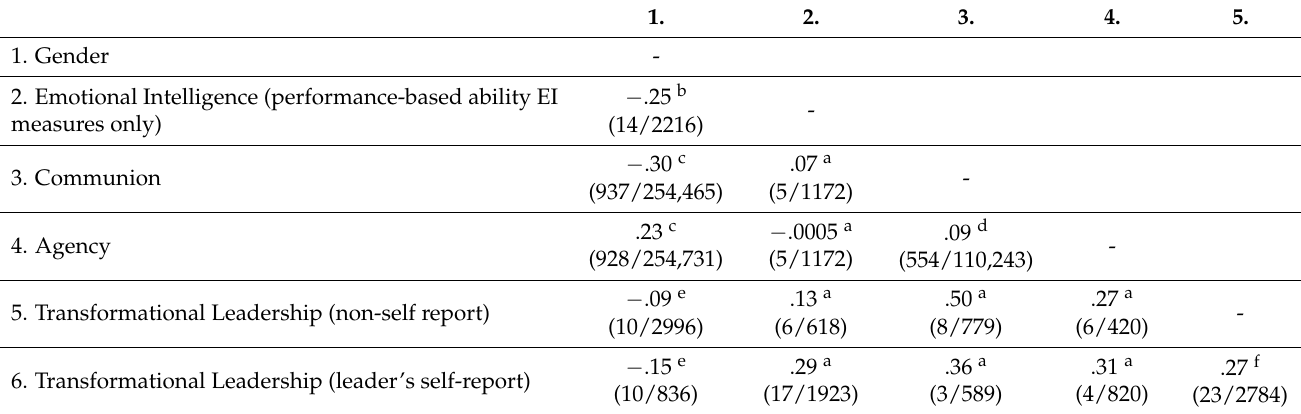
Table 1. Meta-Analytic Correlation Matrix of Gender, Emotional Intelligence, Communion, Agency, and Transformational